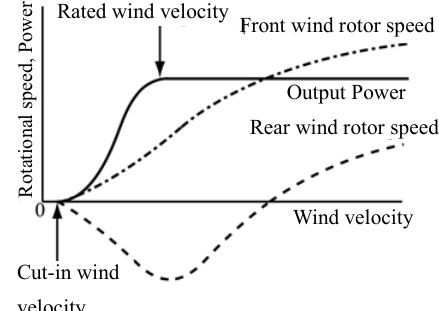
Fig.2 Operation of the intelligent wind turbine unit